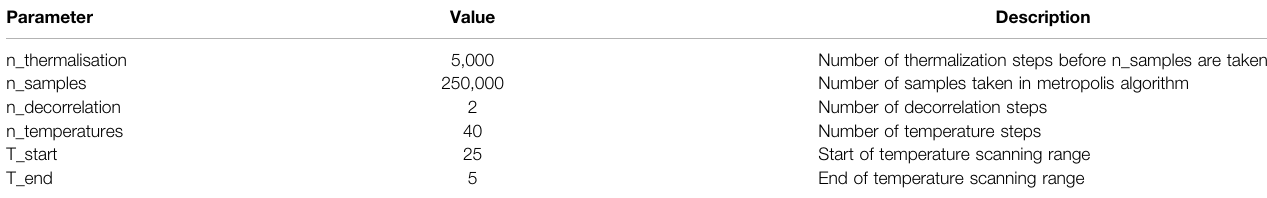
TABLE 2 | Parameters for the MC calculations of the simple-cubic ferromagnet discussed in the text. Note that the chosen settings result in temperature steps of 0.5 K. Parameter